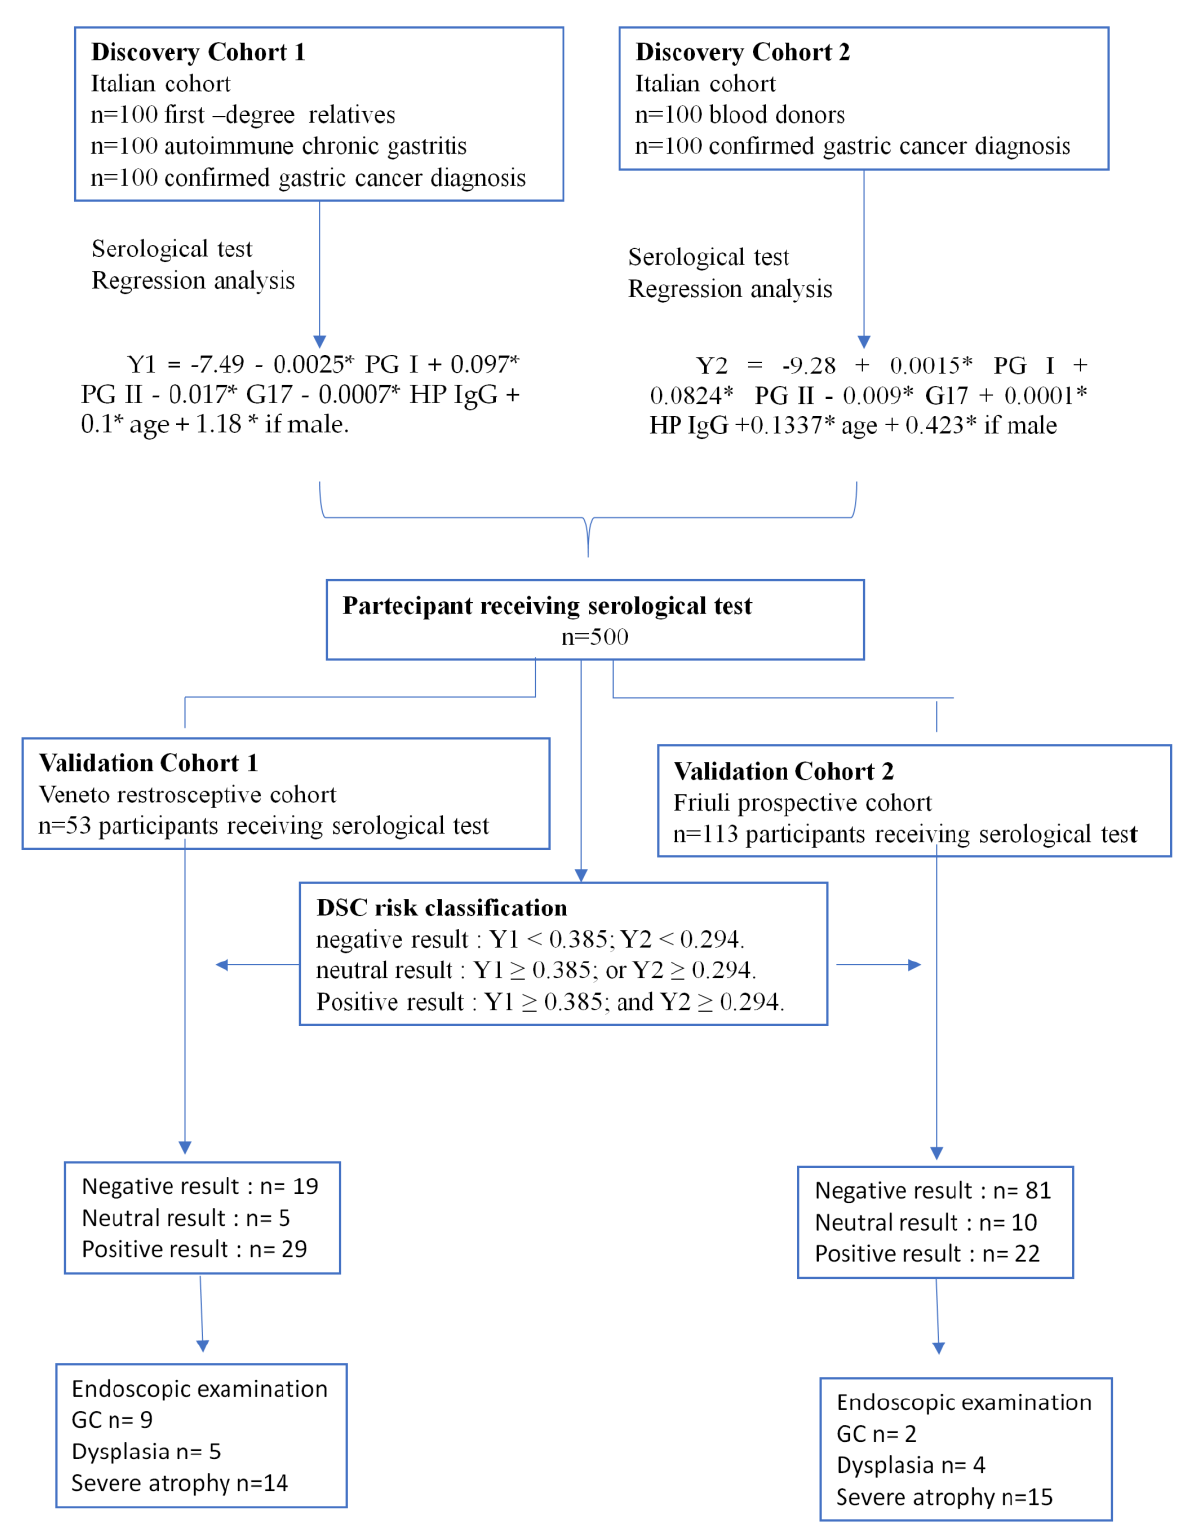
Figure 1. Schematic of the study design and main